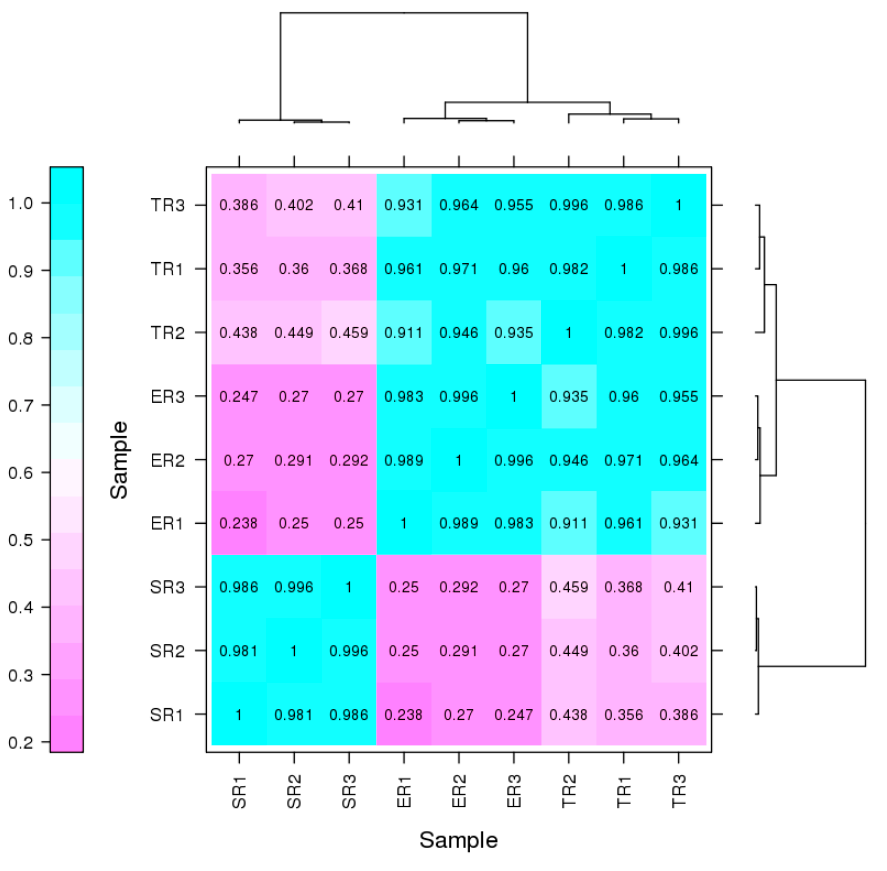
Figure 2. Pearson correlation coefficients for pairwise comparison of transcriptome data. ER, elongation region; TR, transition region; SR, stable region.